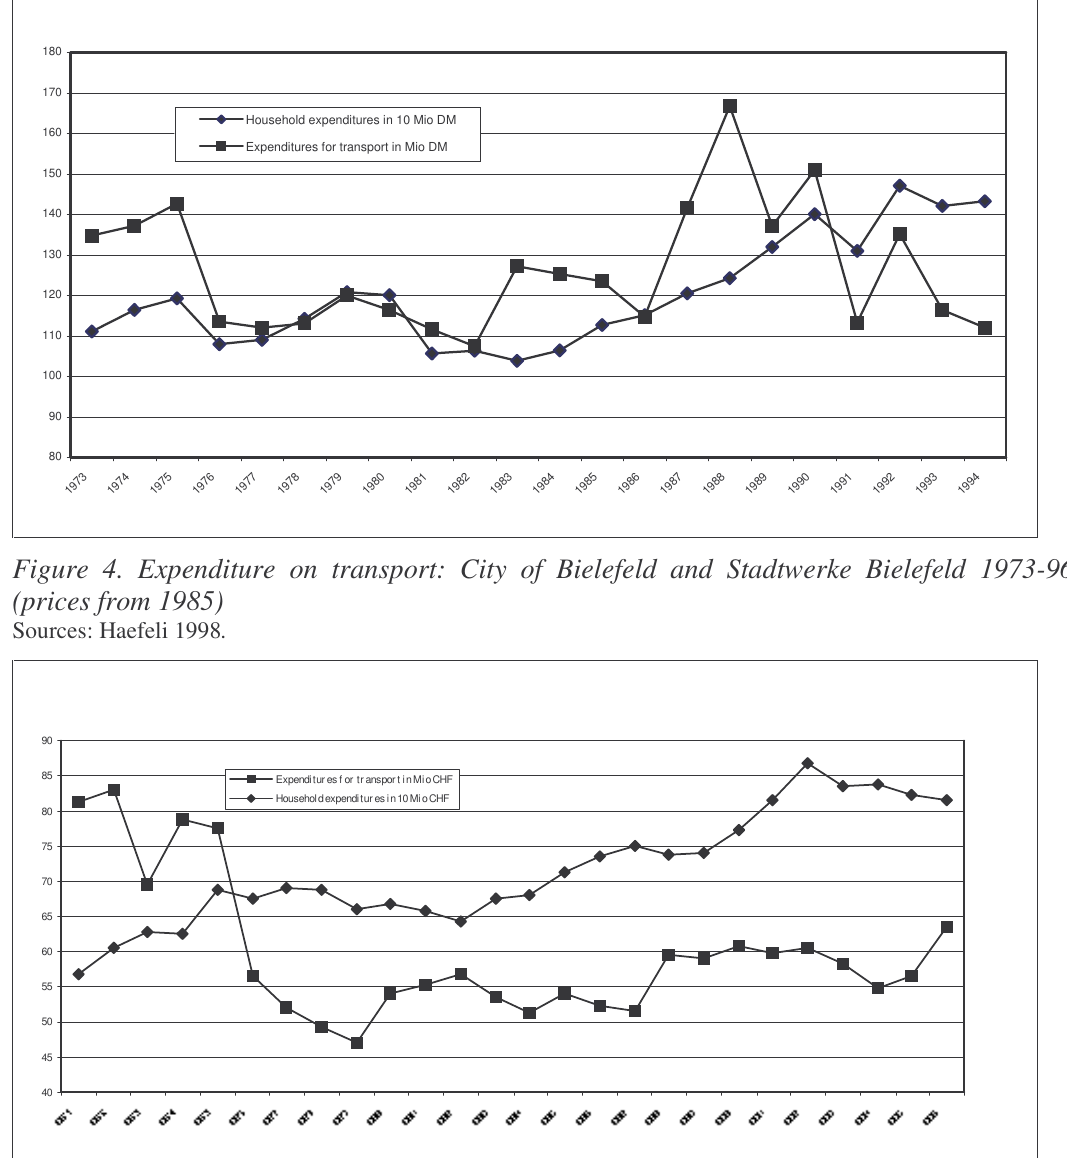
Figure 5. Expenditure on transport: City of Berne1971-95 (prices from 1985) Sources: Gemeinde-Rechnung der Stadt Bern, div. vol., own